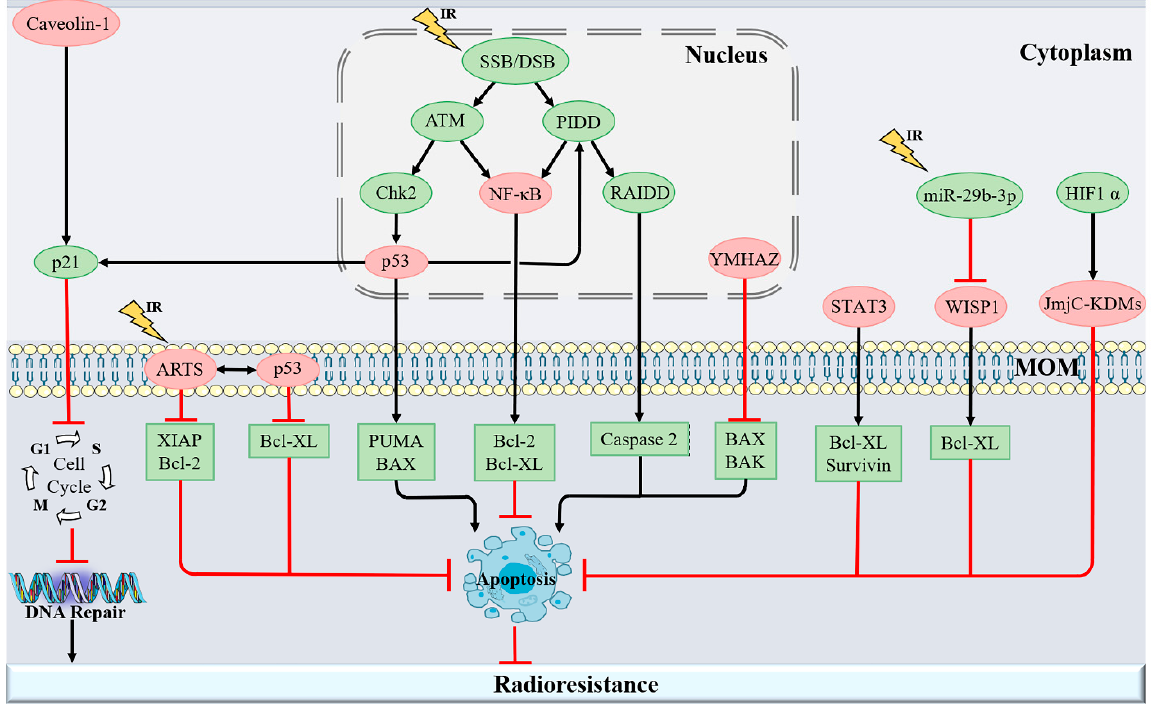
Figure 4. A schematic representation of the signaling mechanism of apoptosis-related molecules. IR induces DNA damage, leading to abnormal expression of mitochondria-related proteins, or directly regulates apoptosis-related genes, thereby promoting DNA damage repair and inhibiting mitochon- drial apoptosis, ultimately causing the occurrence of radioresistance. Abbreviations: SSB/DSB—sin-